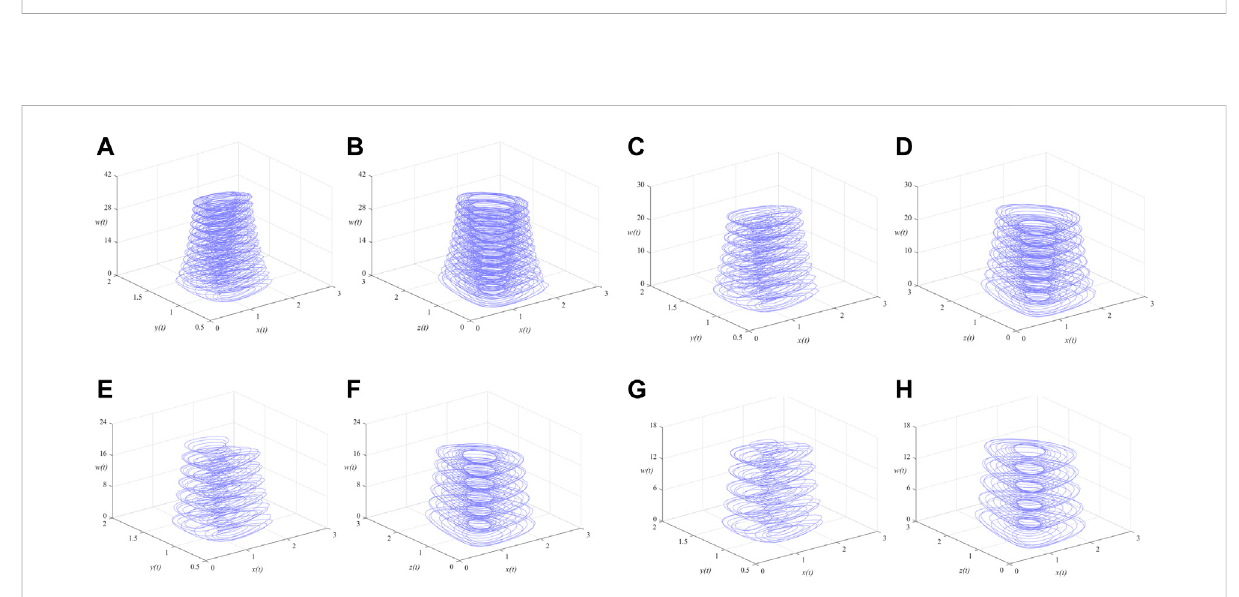
FIGURE 4 Phase portraits of the MSMFrLVS in x - y - w space and x - z - w space: (A,B) : N 1 (cid:4) 2000, (C,D) : N 1 (cid:4) 3000, (E,F) : N 1 (cid:4) 4000, (G,H) : N 1 (cid:4) 5000.